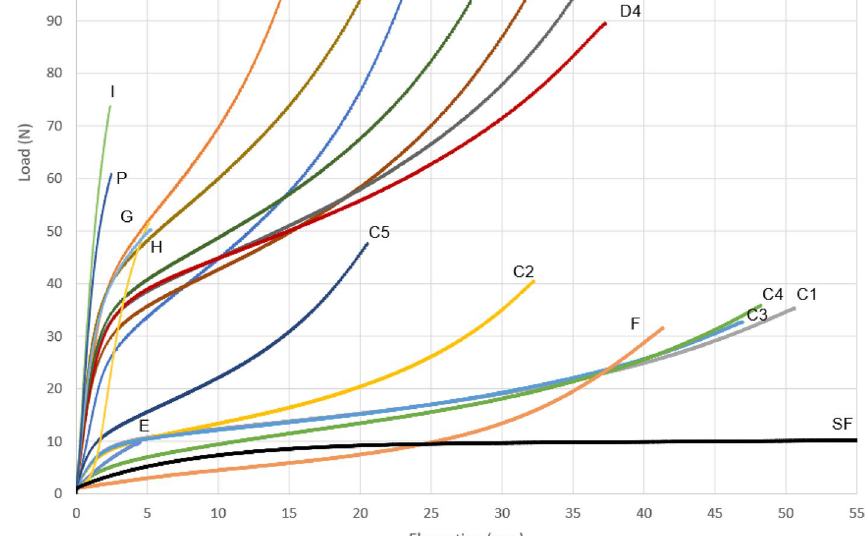
Fig. 7 Normalized averaged results of tensile